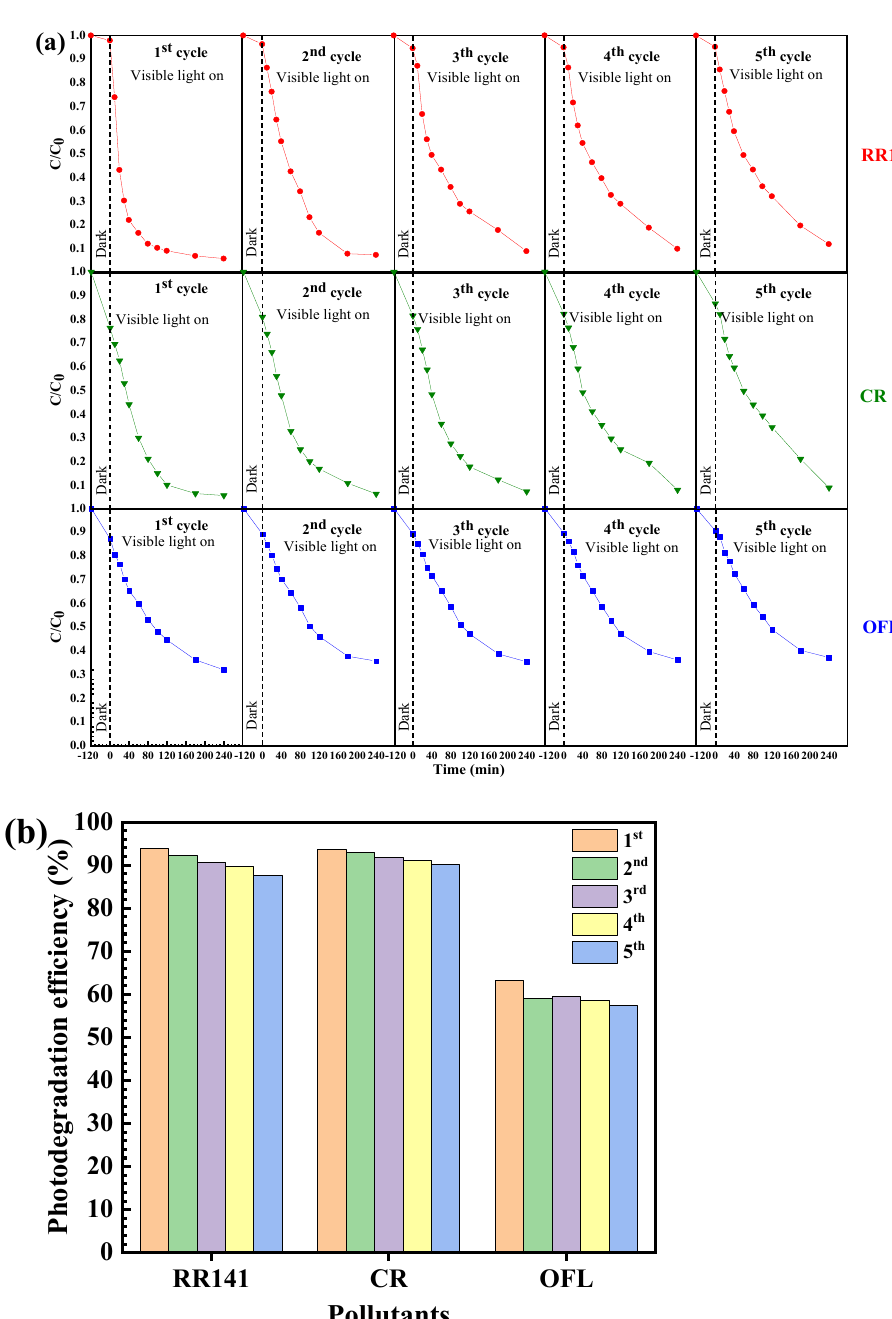
Figure 9. Reusability of the CdS nanoparticles for photodegradation of the RR141, CR dyes, and OFL antibiotic for five cycles under visible light irradiation ( a ), bar chart ( b ) showing the photocatalytic performance of the CdS nanoparticles toward photodegradation of the RR141, CR dyes, and OFL antibiotic for five cycles.